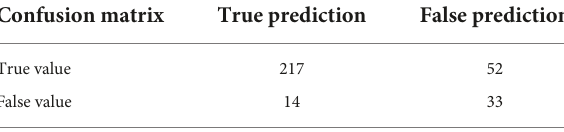
TABLE 6 Confusion matrix for the External I dataset.